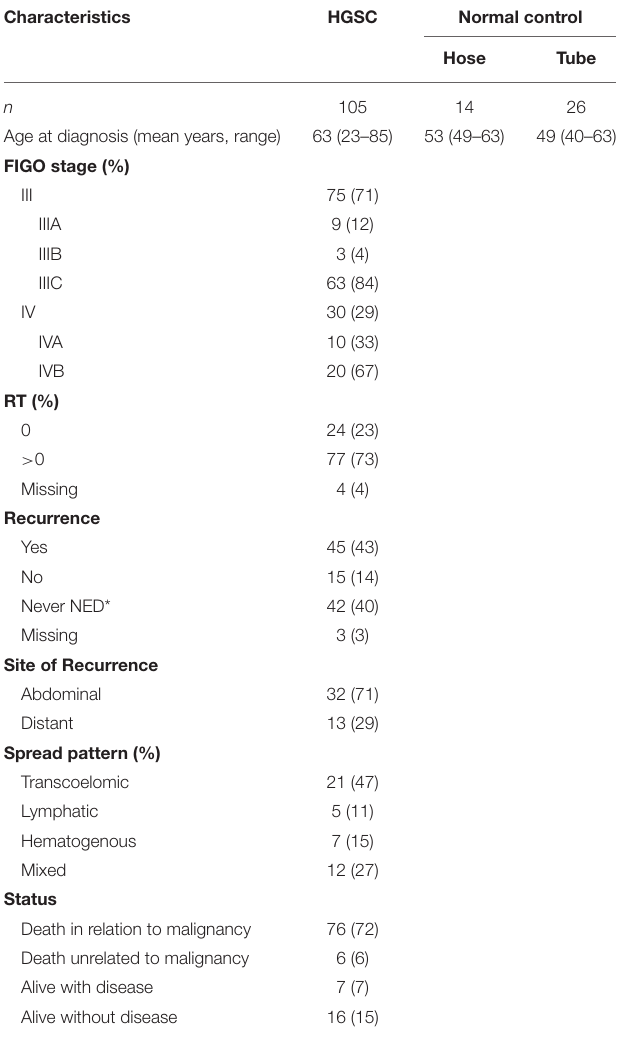
TABLE 1 | Clinicopathological characteristics of 105 HGSOC and 40 normal control patients.